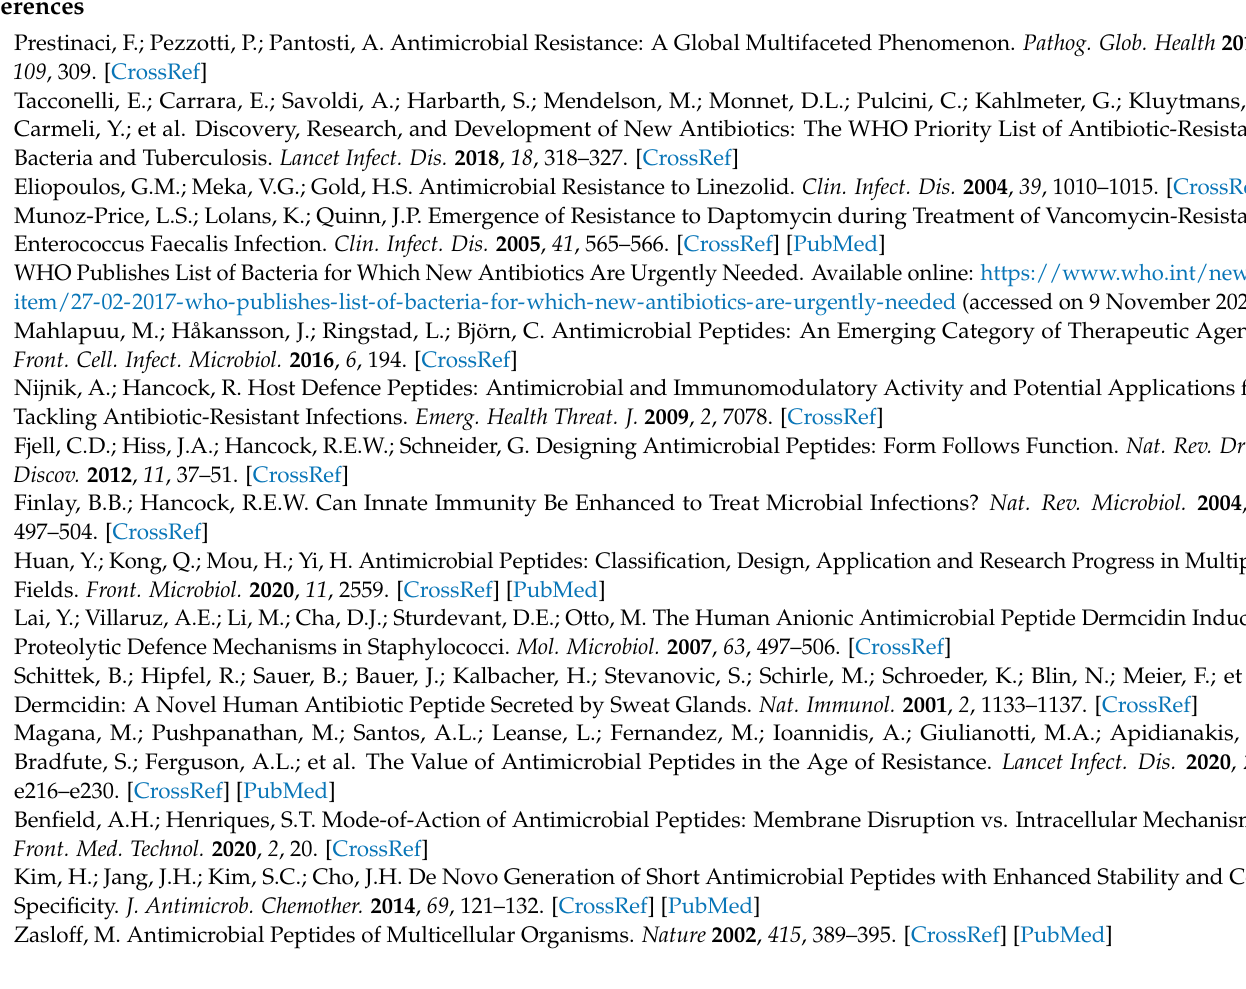
Figure S9: Matrix of labels for the common peptides between training dataset of CalcAFP model and adapted Antifp main validation dataset; Table S8: Comparison of different AFP prediction classifiers using adapted Antifp main validation